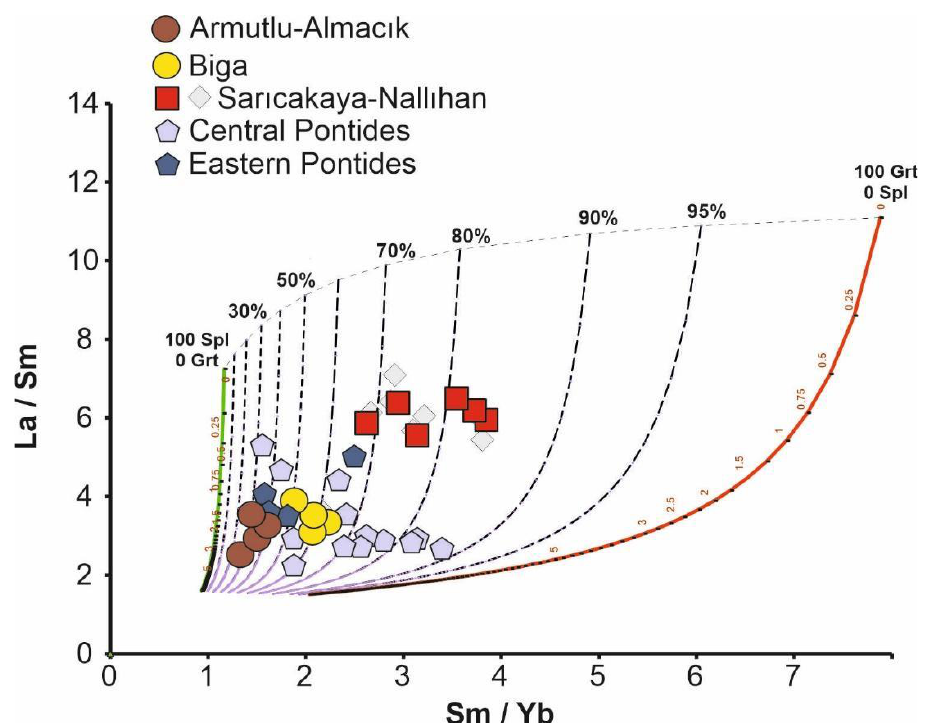
Figure 13. Non-modal batch melting curves for the Early Cenozoic volcanic units from the Balkanatolia Magmatic Realm and different units along northern Turkey on a La/Sm vs. Sm/Yb diagram. Curves were calculated based on the melting of garnet and spinel peridotite sources. Only samples with Mg# >60 are plotted on the diagram. Source modes from [65]. Source modes and melt modes as follows [66,67]: garnet peridotite, Olv0.598 (0.05) + Opx0.211 (0.2) + Cpx0.076 (0.3) + Gt0.115 (0.45), and spinel peridotite, Olv0.578 (0.1) + Opx0.27 (0.27) + Cpx0.119 (0.5) + Sp0.033 (0.13). Distribution coefficients also from [65,67]. Model implemented from [5]. Armutlu –Almacık data from [5]; Biga values from [7,68]; Central Pontides values from [3]; and Eastern Pontides values from [18], references therein. Grey diamonds in the Sarıcakaya–Nallıhan section taken from [25]. Additional information is shown in Supplementary Table S2.